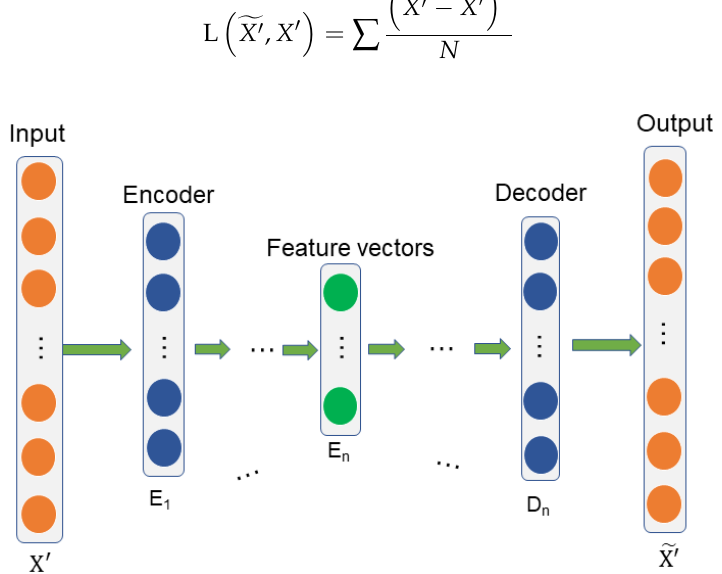
Figure 2. Auto-encoder